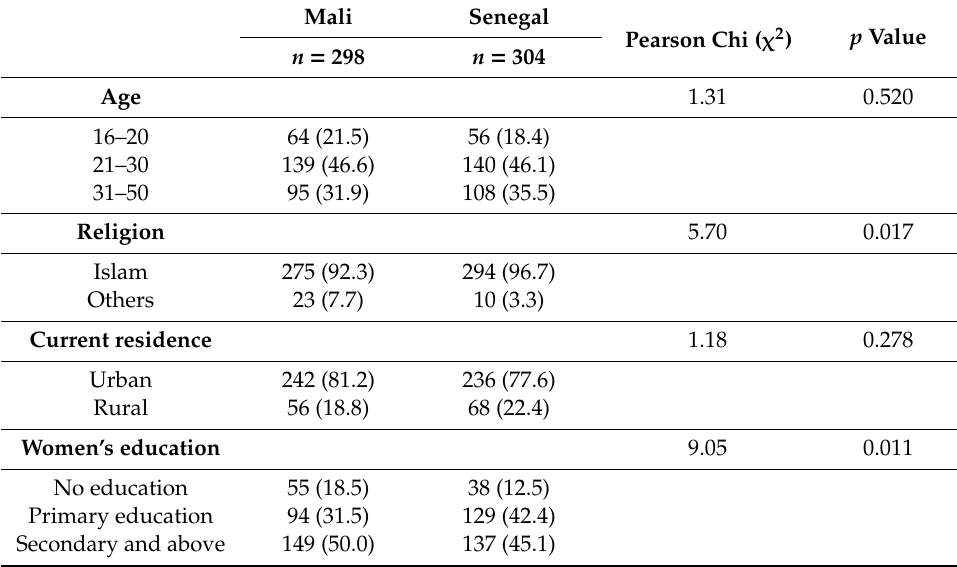
Table 1. Socio-demographic characteristics of